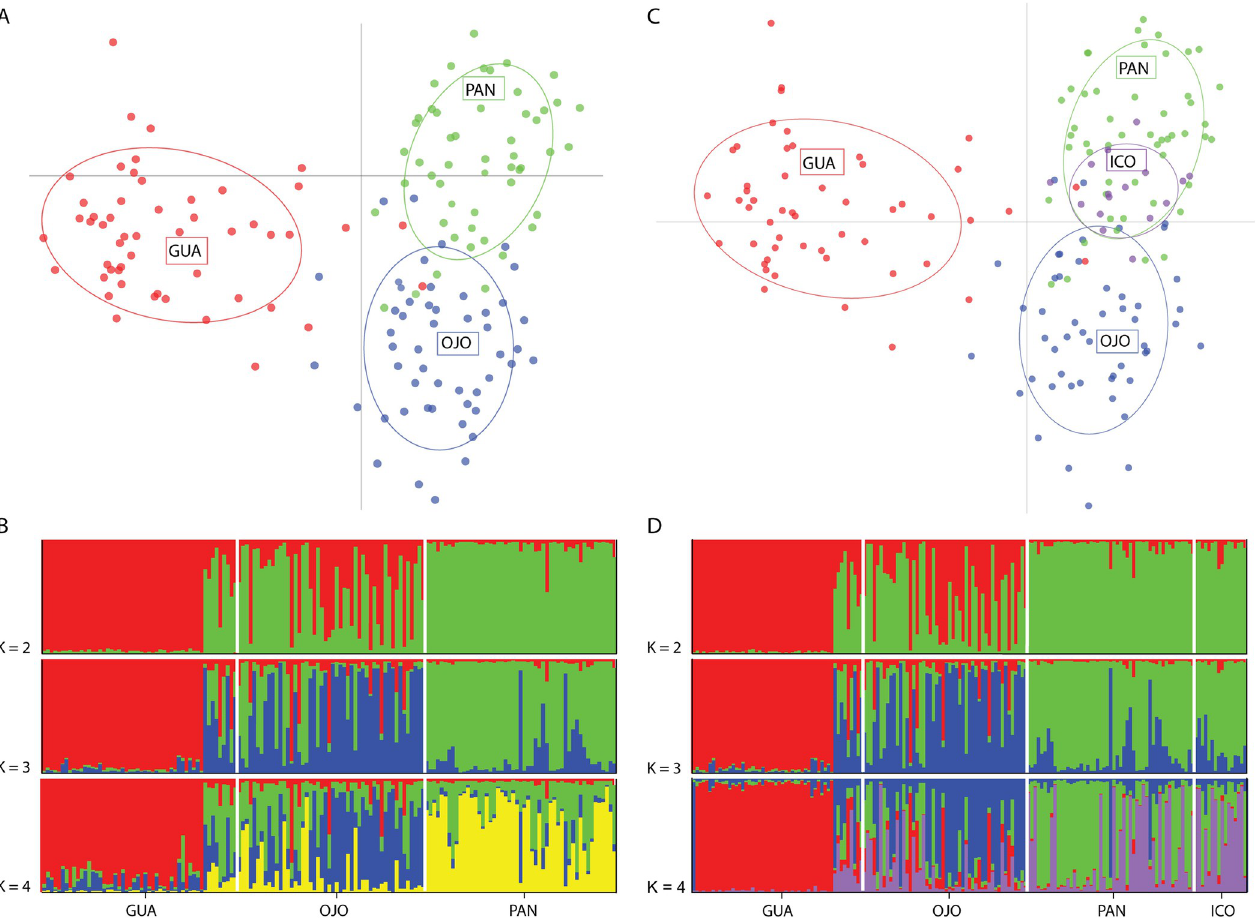
Fig 4. Population structure analyses from microsatellite genotypes of Sphryna lewini individuals in sampling sites of the Eastern Tropical Pacific: Guatemala (GUA), Costa Rica (OJO), Panama (PAN), and Cocos Island (ICO). A) DAPC plot from the first and second components of the nuclear microsatellite genotypes of three coastal areas B) Genetic clusters inferred by STRUCTURE with K = 2, K = 3 and K = 4 of three coastal areas. C) DAPC plot from the first and second components of the nuclear microsatellite genotypes of three coastal areas and an oceanic island. D) Genetic clusters inferred by STRUCTURE with K = 2, K = 3 and K = 4 of three coastal areas and an oceanic